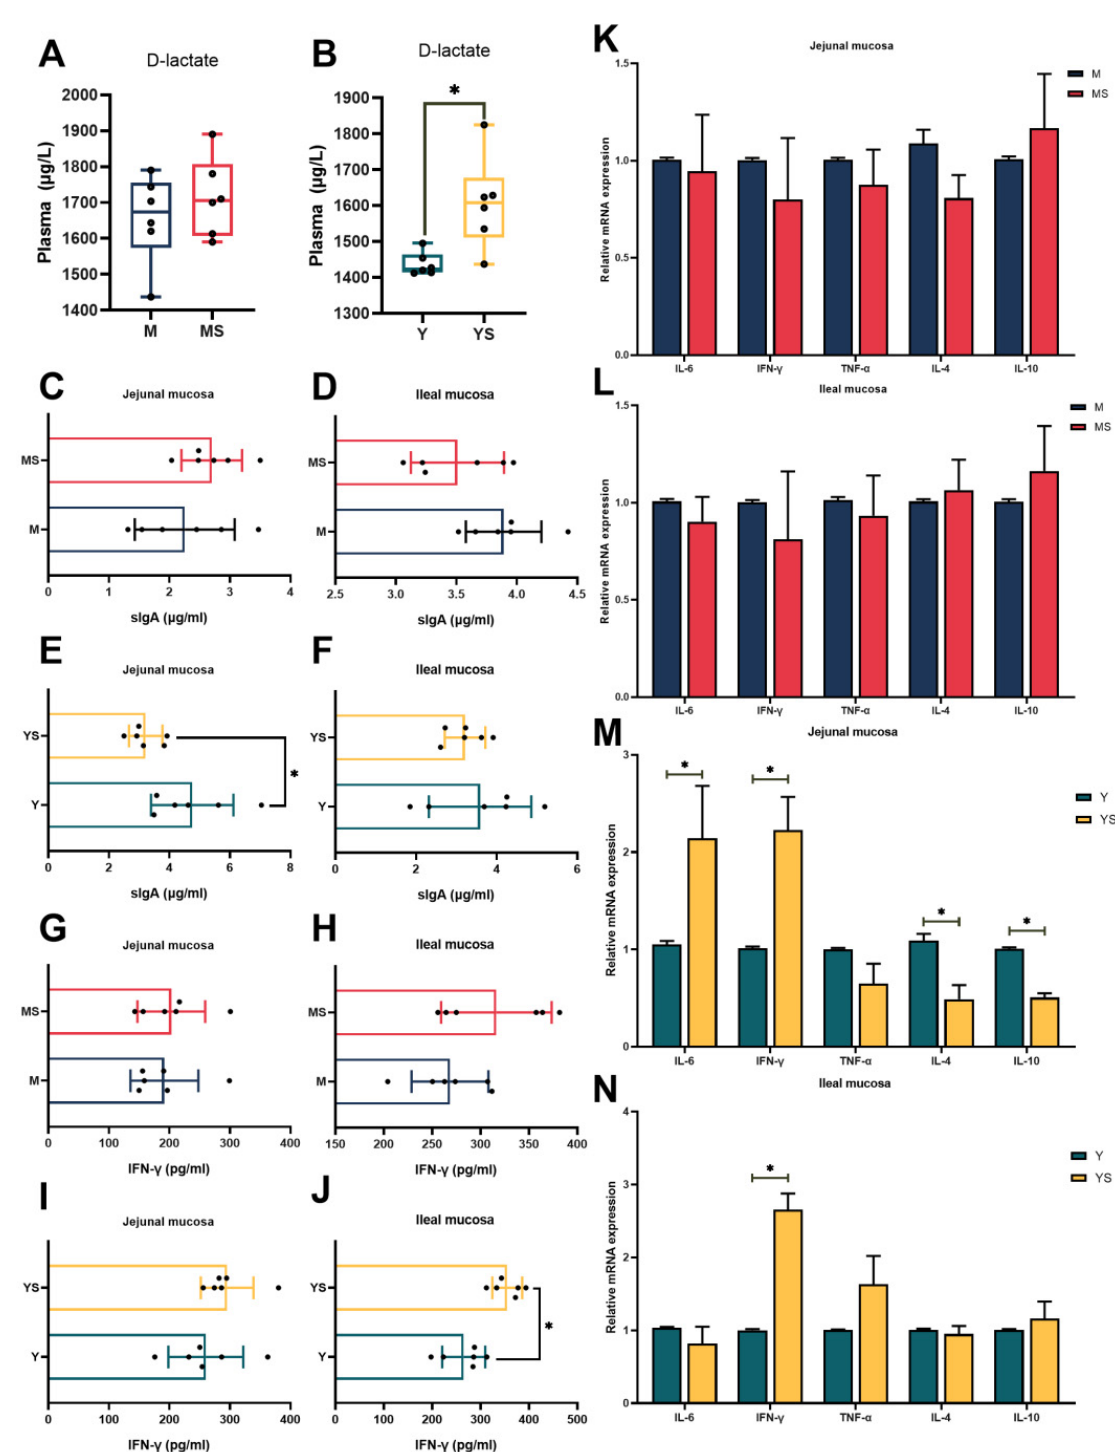
Figure 3. Effects of chronic cold stress on intestinal damage in pigs. ( A ) The level of D-lactate in the plasma of Min pigs (n = 6). ( B ) The level of D-lactate in the plasma of Yorkshire pigs (n = 6). ( C , D ) The content of sIgA in the intestinal mucosa of Min pigs (n = 6). ( E , F ) The content of sIgA in the intestinal mucosa of Yorkshire pigs (n = 6). ( G , H ) The content of IFN- γ in the intestinal mucosa of Min pigs (n = 6). ( I , J ) The content of IFN- γ in the intestinal mucosa of Yorkshire pigs (n = 6). ( K , L ) The mRNA expression levels of inflammatory factors in Min porcine intestinal mucosa (n = 6). ( M , N ) The mRNA expression levels of inflammatory factors in Yorkshire porcine intestinal mucosa (n = 6). Data are presented as the means ± SEM. * p < 0.05. 2.3. Chronic Cold Stress Induces Small Intestinal Mucosal Injury by Modulating TLR4/MyD88 Signaling Pathway In order to determine whether chronic cold stress caused collective injury through the TLR4/MyD88 signal pathway, we analyzed the expression of related genes. From Figure 4, compared with the Y group, the mRNA and protein expression levels of TLR4 and MyD88 in jejunum mucosa of the YS group was considerably increased ( p < 0.05,